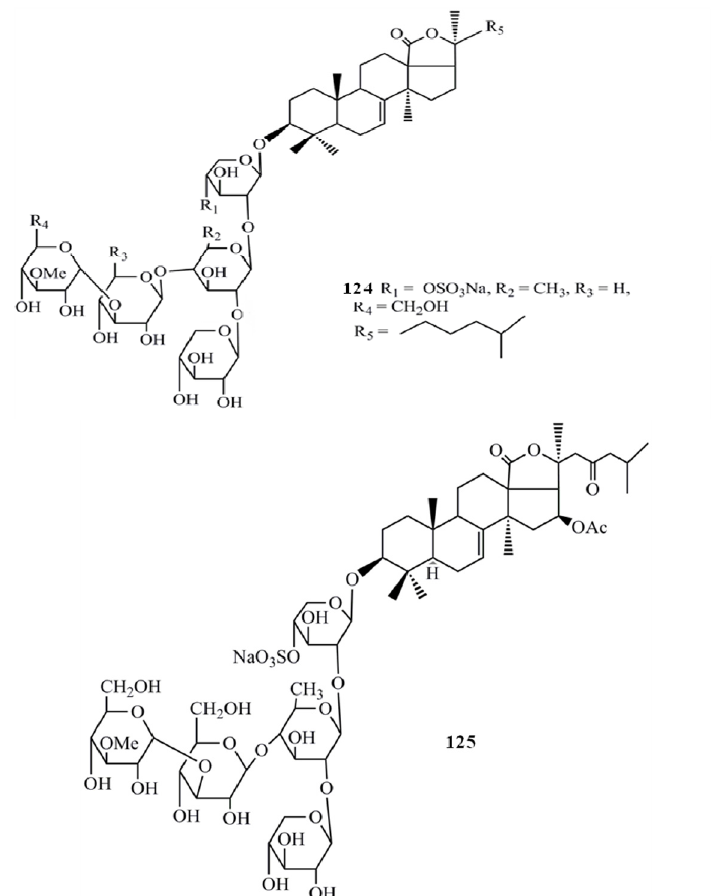
Figure 16. Triterpenoid glycosides frondoside A, cucumarioside A2-2 from sea